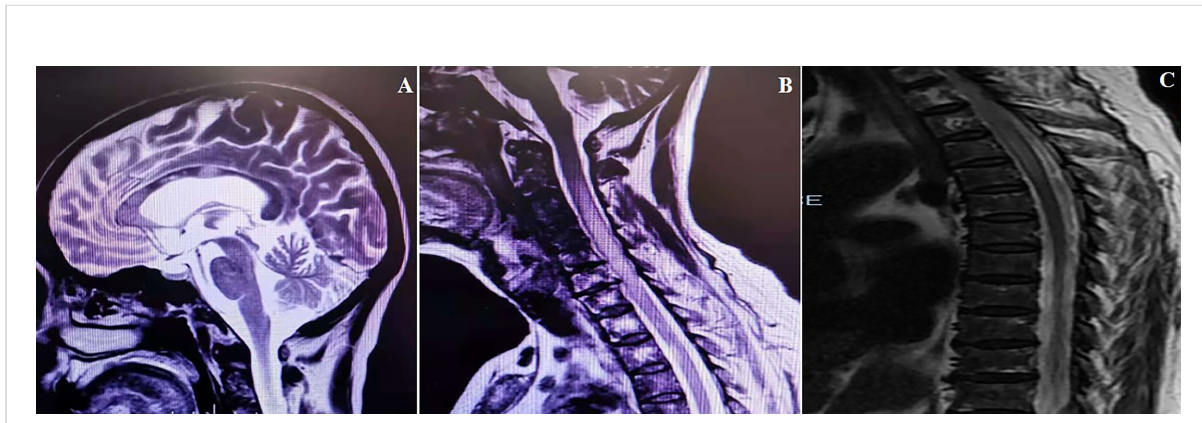
FIGURE 1 MRI scans obtained at the time of the fi rst attack. (A) Cerebral MRI (sagittal T2 image) exhibiting disseminated lesions in corpus callosum. (B, C) Spinal MRI (sagittal T2 image) exhibiting longitudinally extensive lesion from C3 to